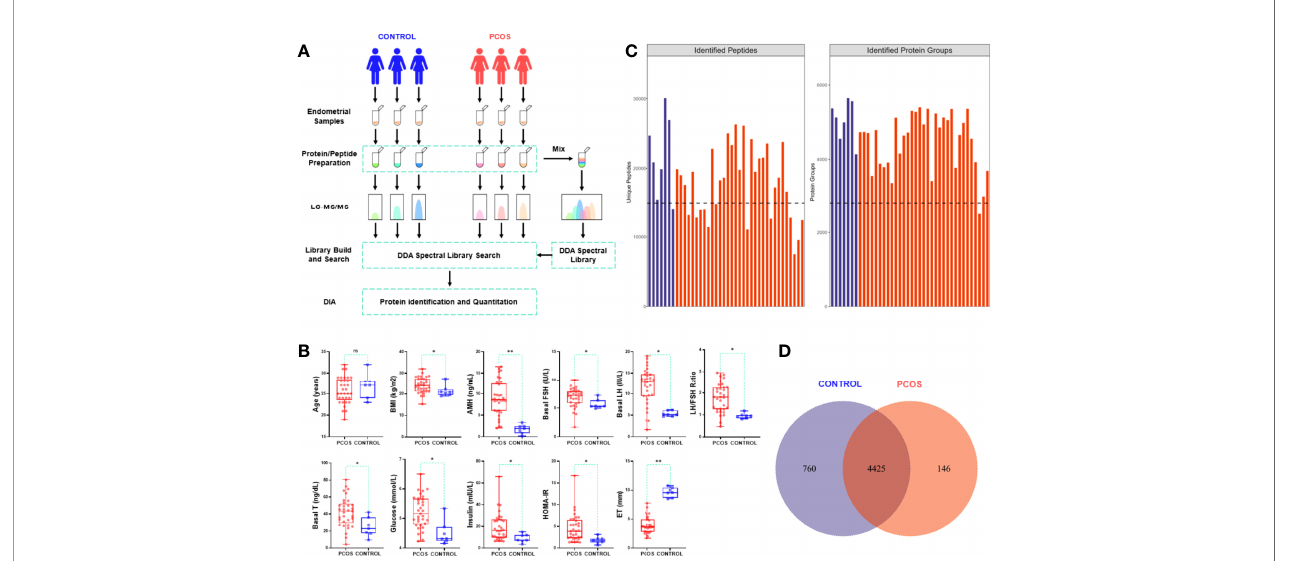
FIGURE 1 | Protein identi fi cation analysis and clinical data